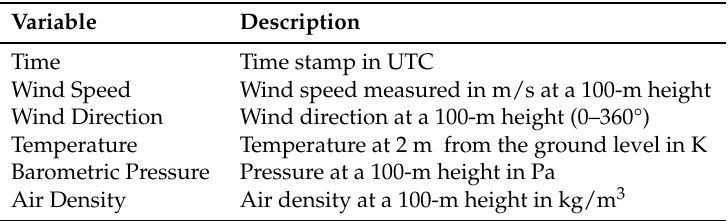
Table 2. Variables in an NREL wind dataset time